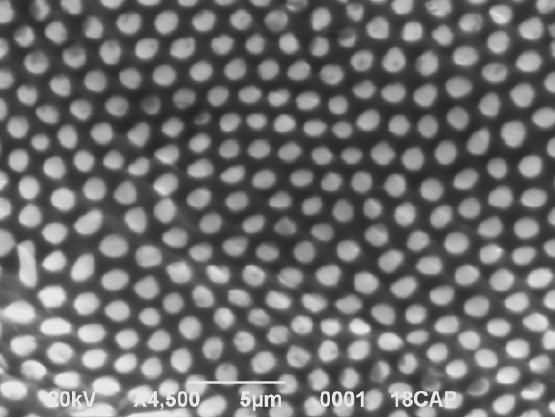
Figure 4. SEM images of crystallites at the transverse cut: ( a ) × 300 magnification; ( b ) × 4000 magnification.